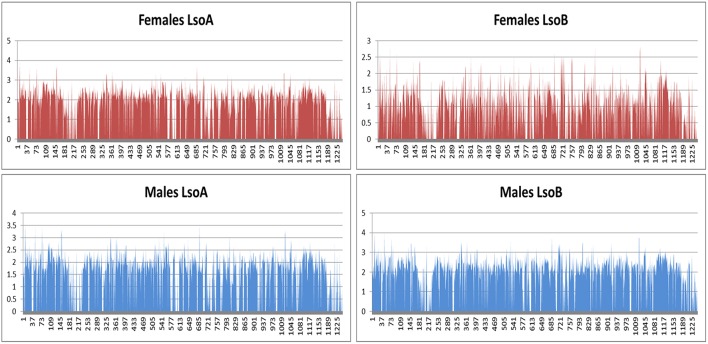
Gene expression across Lso genome. The x-axis shows the gene order in Lso B genome and the y-axis shows log(RPKM+1) value for each gene. Values for rRNA were changed to 0 for readability purposes.